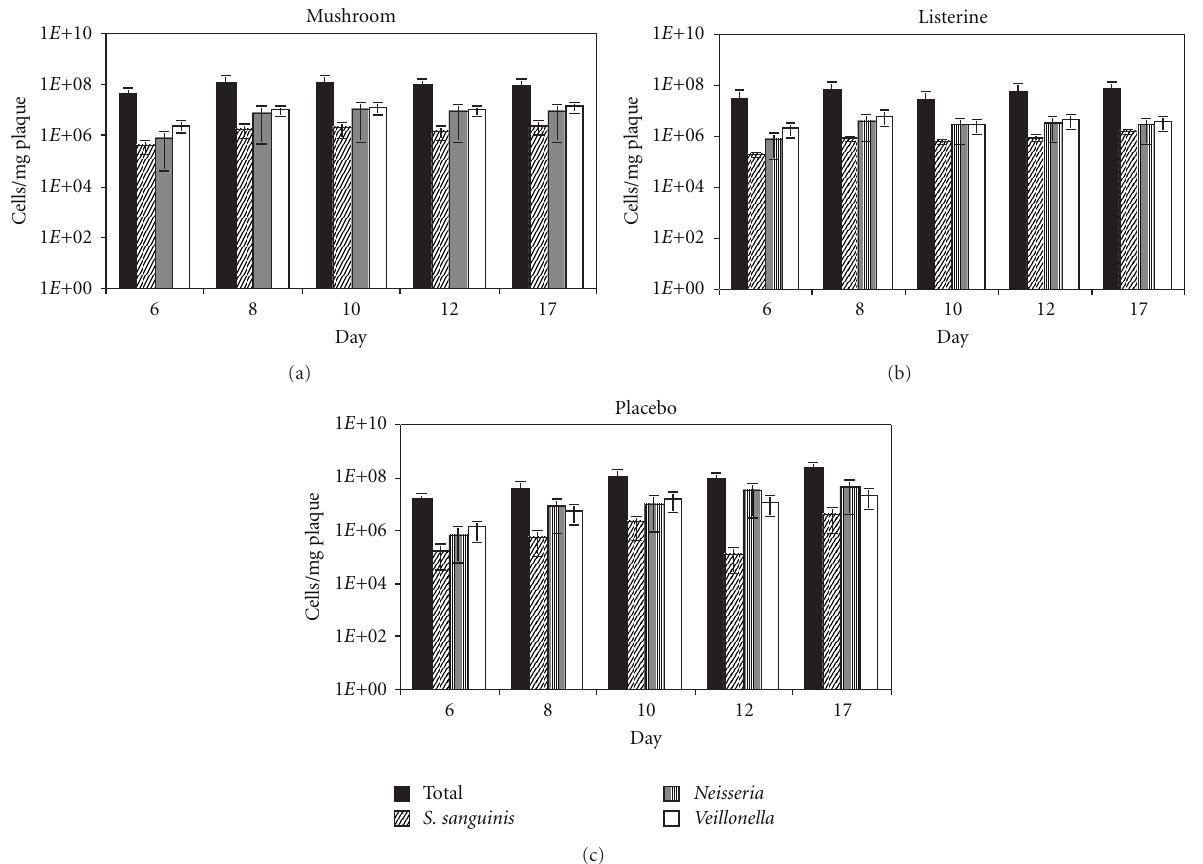
Figure 4: Numbers of each of the investigated taxa associated with oral health and total counts in dental plaque samples of the three cohorts enrolled in the study. Standard error bars represent the standard deviation ( n =